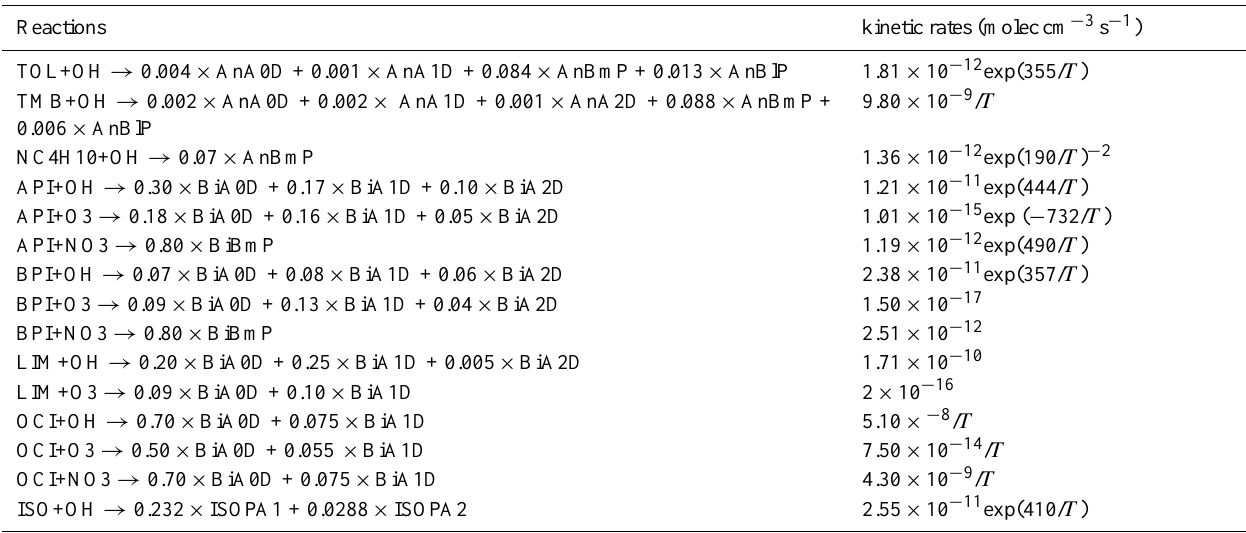
Table 6. Gas-phase chemical scheme for SOA formation in CHIMERE. The surrogate SOA compounds consist of six hydrophilic species that include an anthropogenic non-dissociative species (AnA0D), an anthropogenic once-dissociative species (AnA1D), an anthropogenic twice-dissociative species (AnA2D), a biogenic non dissociative species (BiA0D), a biogenic once-dissociative species (BiA1D) and a biogenic twice-dissociative species (BiA2D); three hydrophobic species that include an anthropogenic species with moderate saturation vapour pressure (AnBmP), an anthropogenic species with low saturation vapour pressure (AnBlP) and a biogenic species with moderate saturation vapour pressure (BiBmP); and two surrogate compounds for the isoprene oxidation products.